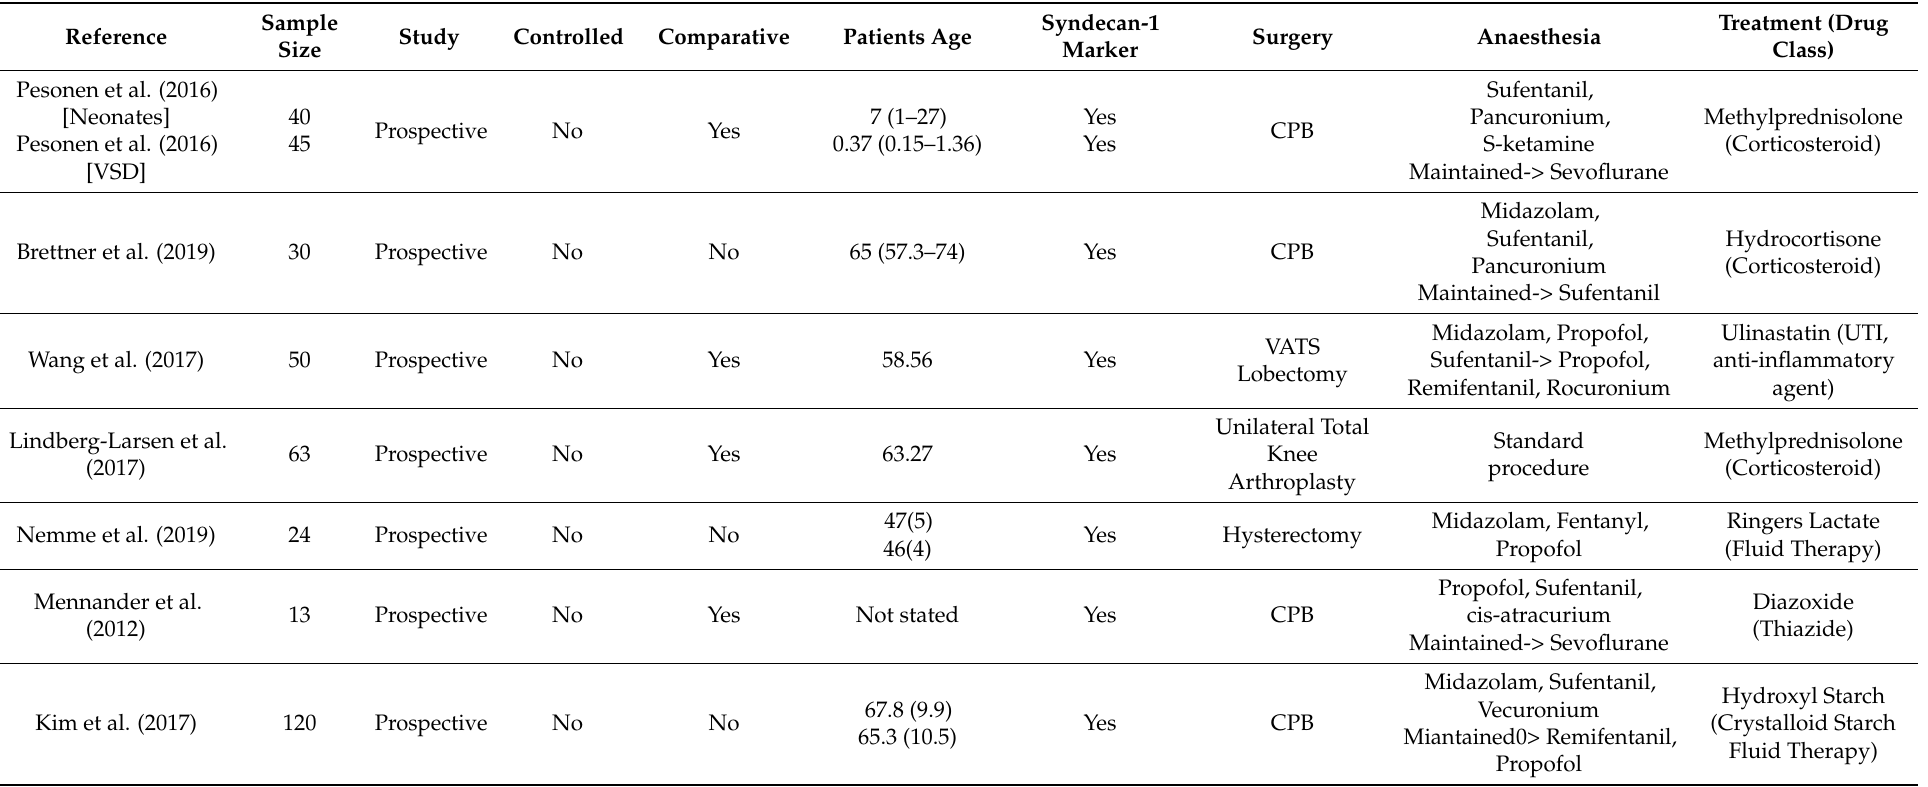
Table 1. Publications included for review of protective treatments for EG degradation in